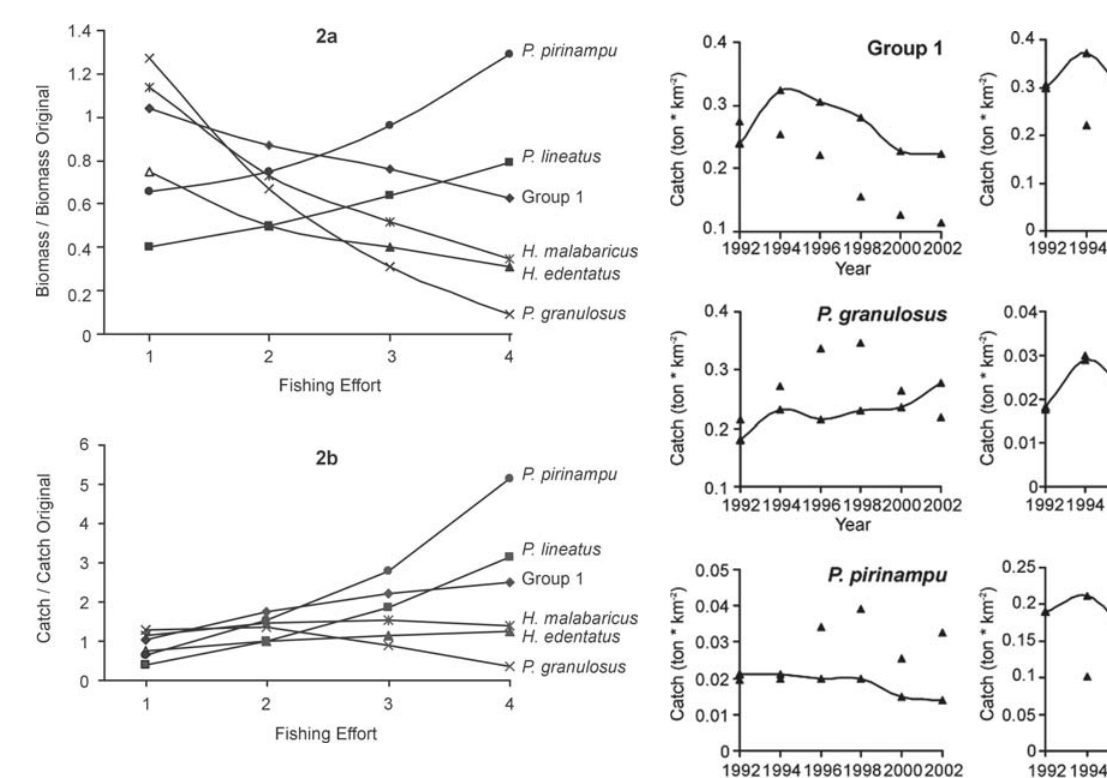
Fig. 2. Relative biomass (2a) and relative catch (2b) of the main species of the I TAIPU -2 model, with increasing of fishing effort. Fishing effort = 1 is equivalent to that registered in 1998. This value was multiplied by 2, 3 and 4, in order to get other fisheries scenarios. Simulations made in Ecopath with Ecosim (Subroutine: Run Ecossim, module: Results).